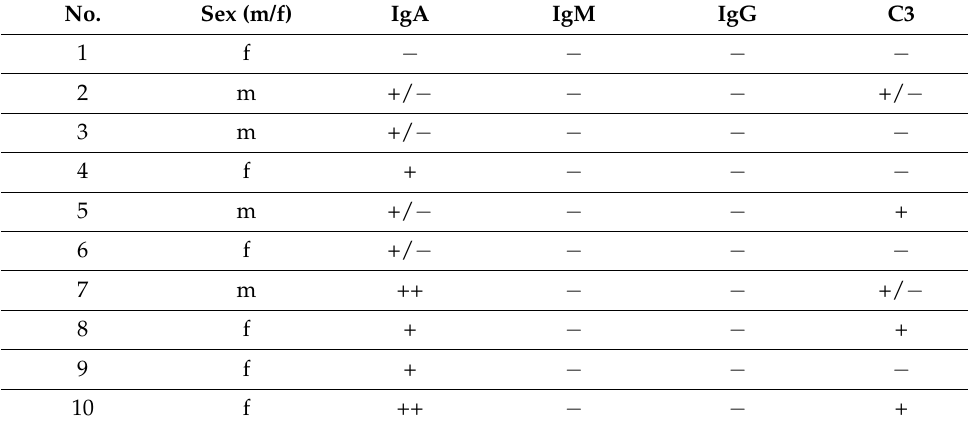
Table 1. DIF results of the oral mucosa bioptats in the study participants with DH. DIF—direct immunofluorescence, f—female, m—male, +/ − indeterminate DIF result, + moderate fluorescence intensity, ++ significant fluorescence intensity, − no deposits detected, Ig—immunoglobulin. No.